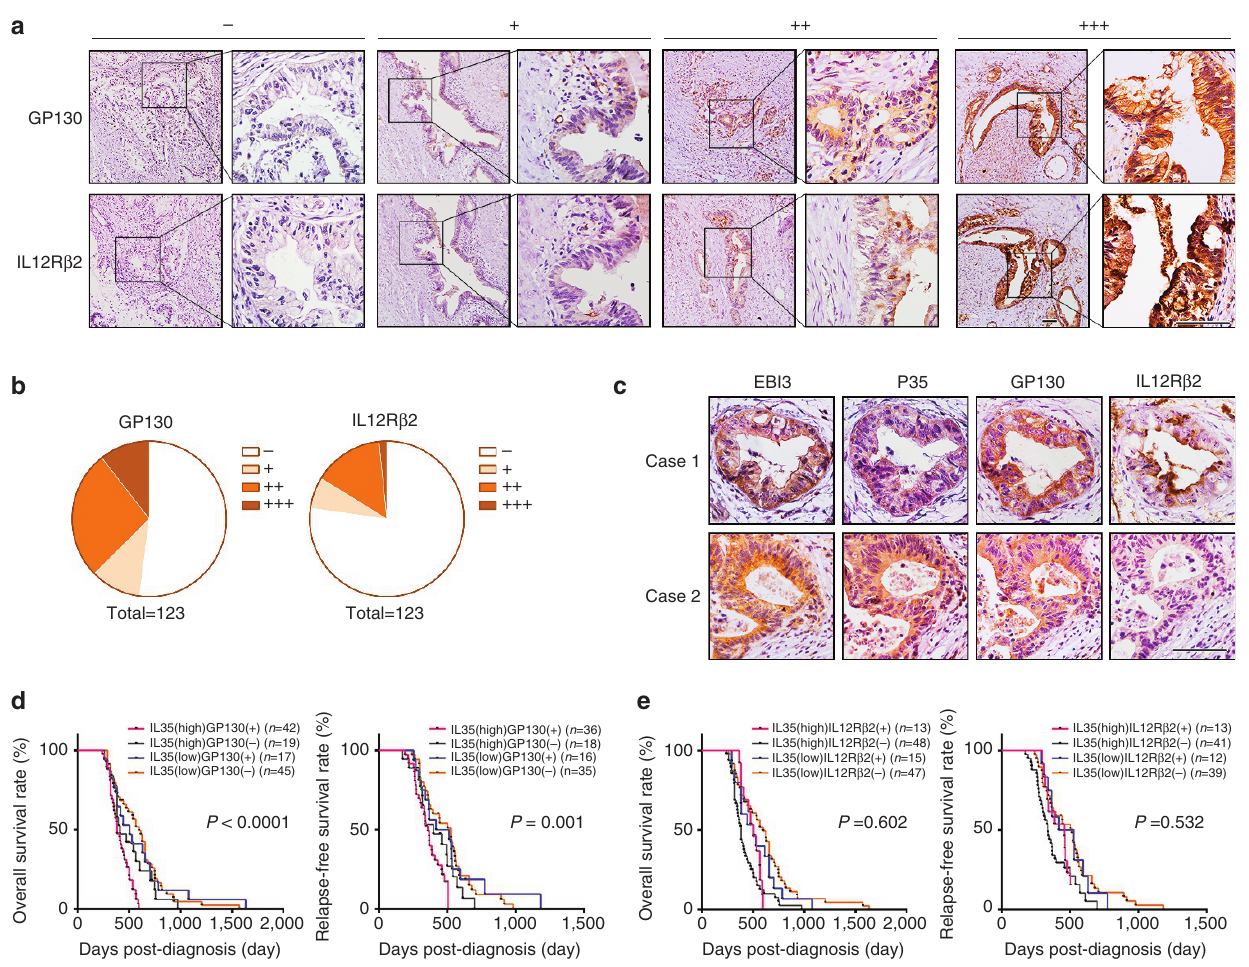
Figure 7 | GP130 expression is essential to the IL-35-associated poor prognosis of patients with PDAC. ( a ) Examples are shown for absent, low, median and high expressions of GP130 and IL-12R b 2 in PDAC tissues. Figure panel pairs represents images taken with different zooming options; scale bars, 100 m m. ( b ) Real distribution of IHC results of GP130 and IL-12R b 2. ( c ) Examples are shown for the co-expression of IL-35 and IL-35R in PDAC tissues; scale bars, 100 m m. ( d ) Kaplan–Meier analysis of OS (left) and RFS (right) of 123 PDAC patients according to the expression levels of IL-35 and GP130. ( e ) Kaplan–Meier analysis as in d but according to the expression levels of IL-35 and IL-12R b 2. Log-rank tests were used in d and e